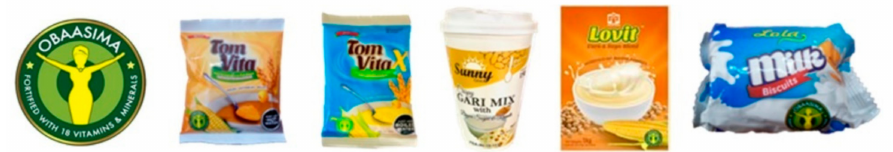
Figure 2. Examples of nutritious products bearing the front-of-pack OBAASIMA seal (shown left), which guarantees a product is fortified with 18 vitamins and